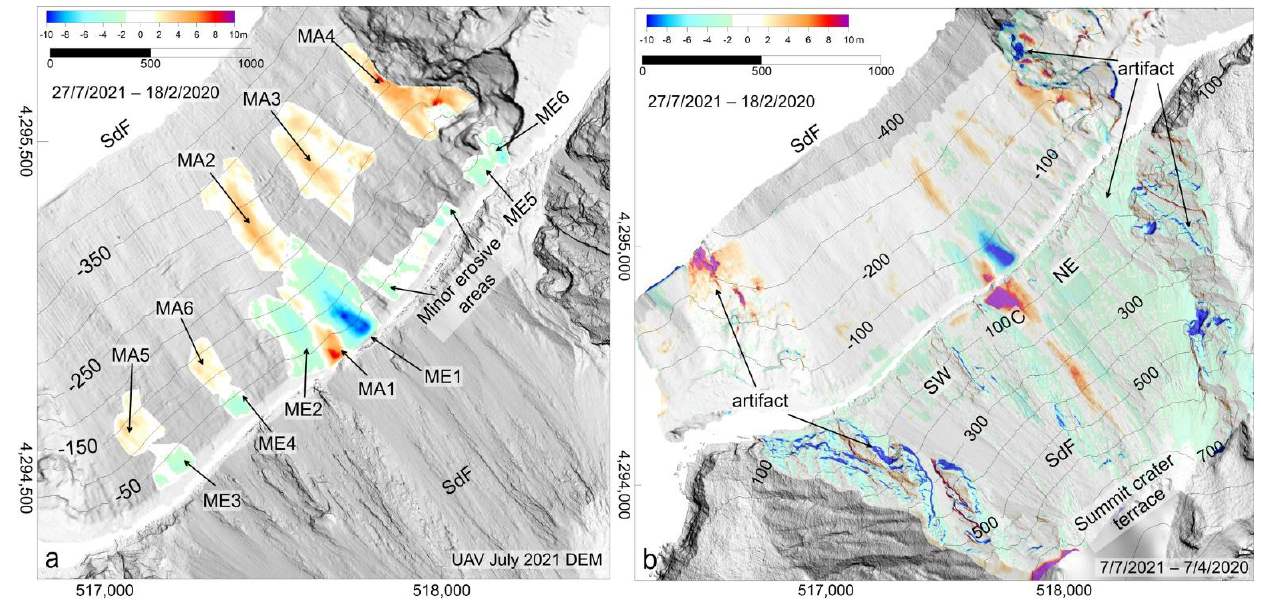
Figure 5. ( a ) Elevation difference map (cleaned for the residual mismatching between DEMs) between the July 2021 and February 2020 bathymetries draped over the 2021 DEM; ME and MA for marine erosion and accretion, respectively. ( b ) Elevation difference map for the subaerial (July 2021–April 2020) and submarine (July 2021–February 2020) SdF draped in semi-transparency over the July 2021 submarine and subaerial DEMS; note that the elevation difference maps were not cleaned to show the distribution and the magnitude of the residual mismatching between the first and the last DEMs.